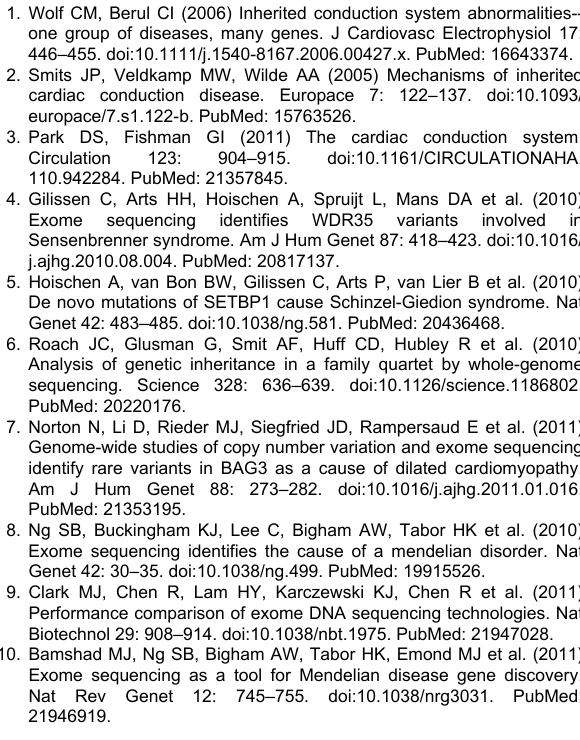
Table S2. Indel variants that pass the filtering criteria and match to the autosomal dominant pedigree.